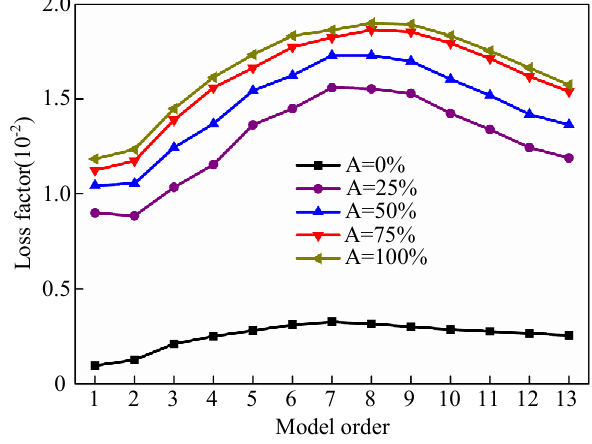
Figure 11. Modal loss factors of mistuned blisks with different coating areas.